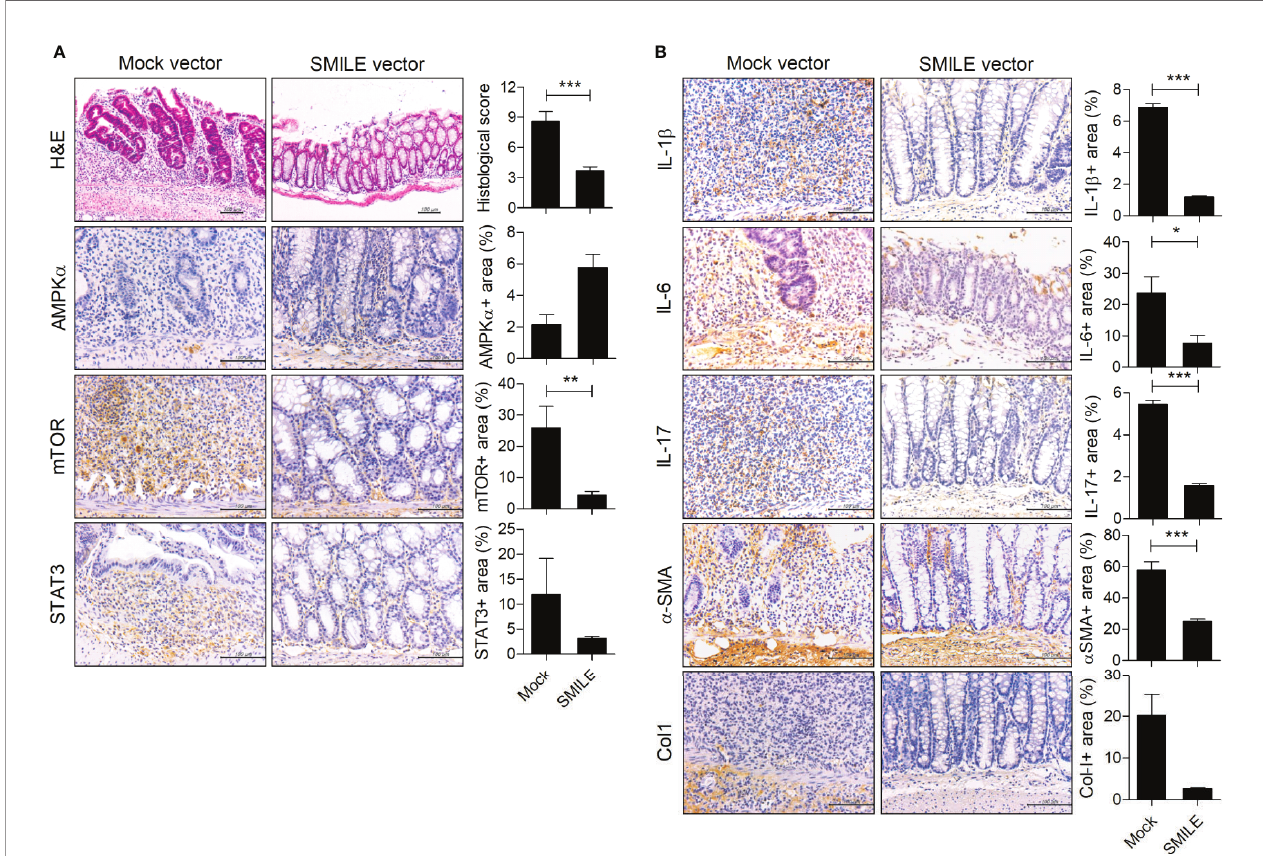
FIGURE 3 | SMILE decreases in fl ammation and fi brosis in DSS-induced colitis. H&E and IHC staining of the colon of C57BL/6 mice with DSS-induced colitis and administered SMILE vector (100 m g/mL) (n = 5 per group). Representative images are shown. (A) H&E staining and IHC with anti-mTOR, -AMPK, and -STAT3 antibodies. (B) IHC with anti-IL-1 b , -IL-6, -IL-17, - a -SMA, and -collagen-1 (Col1) antibodies. Bars are percentages of positive areas per fi eld. Data are means±SEM of two replicates. * P < 0.05, ** P < 0.01, *** P <